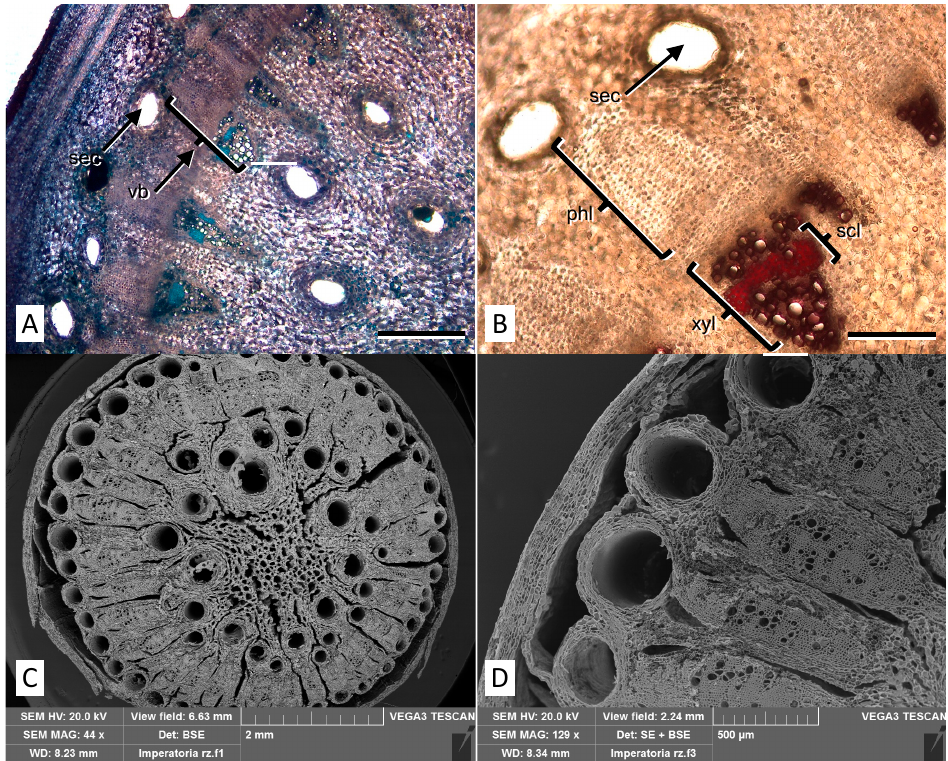
Figure 3. Micromorphological features of the P. ostruthium rhizome. ( A ) Light microscopy view of a cross section stained with TBO: different vascular bundles (vb) and secretory channels (sec) are visible. Bar 500 µm. ( B ) Detail of a cross-section after phloroglucinol-HCl staining, showing xylem vessels (xyl) interspersed with sclerenchyma fibers stained in purple/red (scl). sec: secretory channel; phl: stratified phloem. Bar 200 µm. ( C ) SEM micrograph of a cross section of an old rhizome, where the high number of vascular bundles and secretory channels are highlighted. ( D ) Detail of ( C ) at higher magnification.